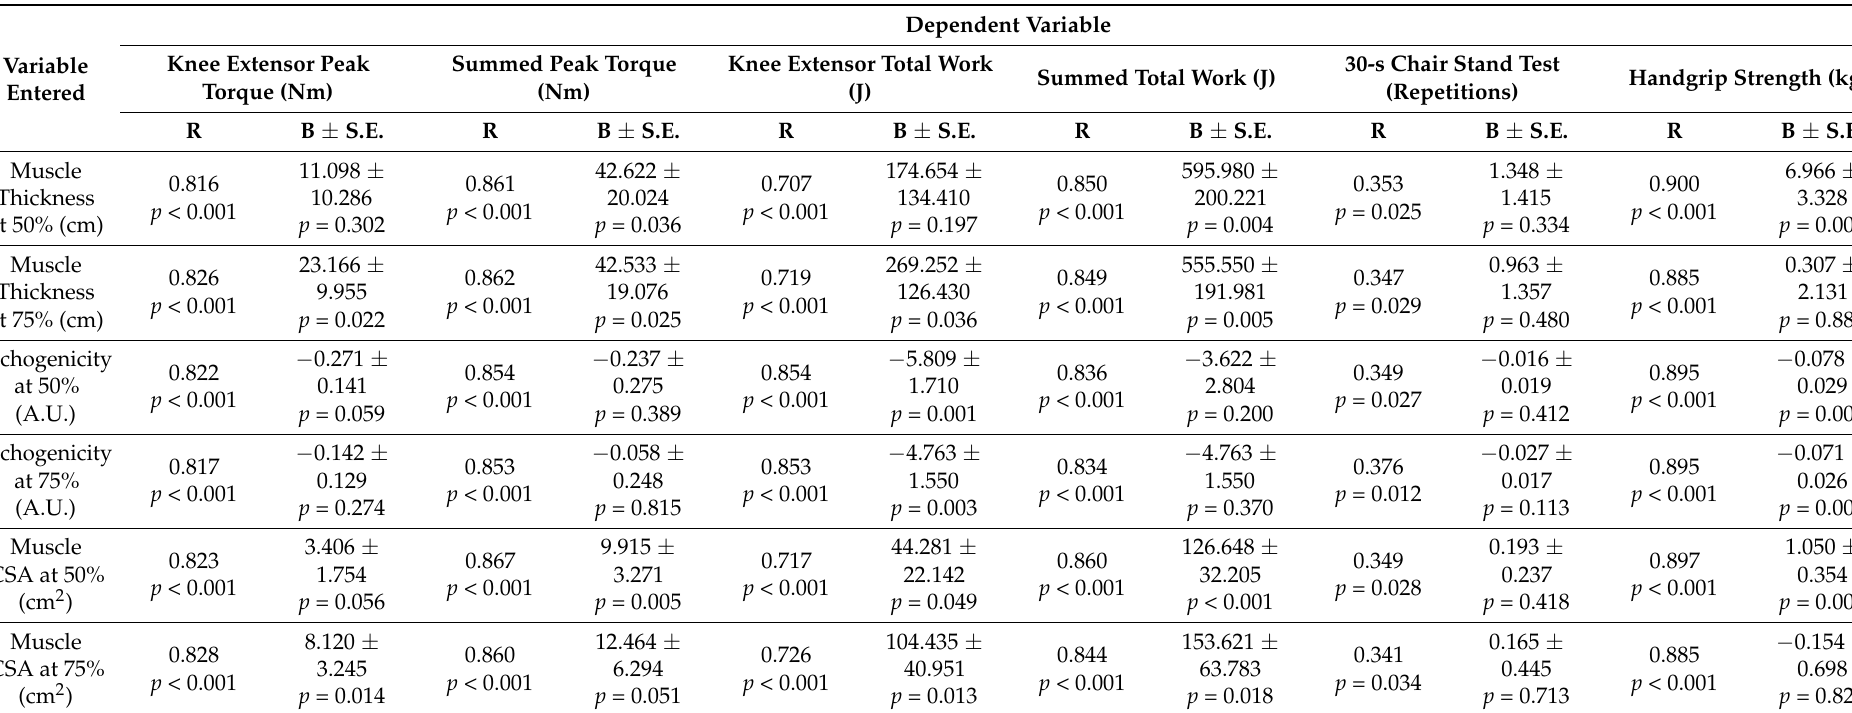
Table 3. The associations between different ultrasonographic measures of the right rectus femoris using the panoramic feature (50% of leg upper length) and a B-mode image (75% of upper leg length) in a sample of 88 middle-aged men and women when controlling for age, gender, and